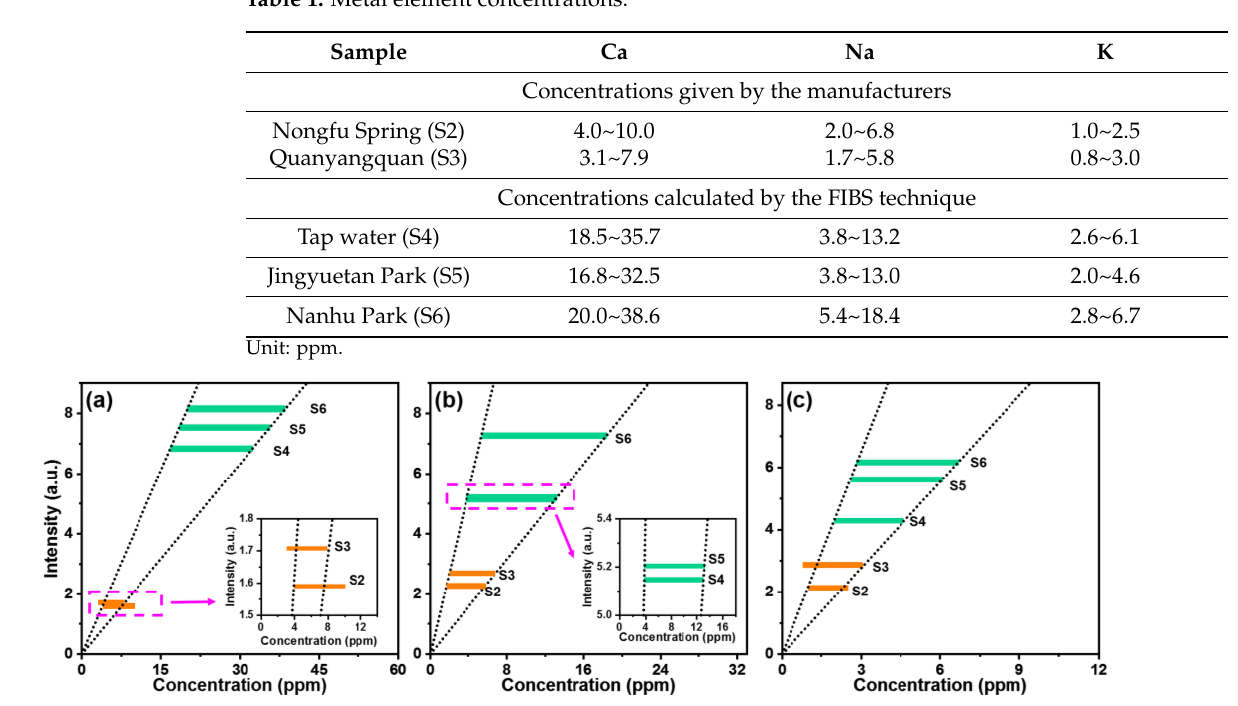
Figure 6. Concentration evaluation of Ca ( a ), Na ( b ), and K ( c ) of Samples S4–S6 based on the concentration data of Samples S2 and S3 given by the manufacturers.